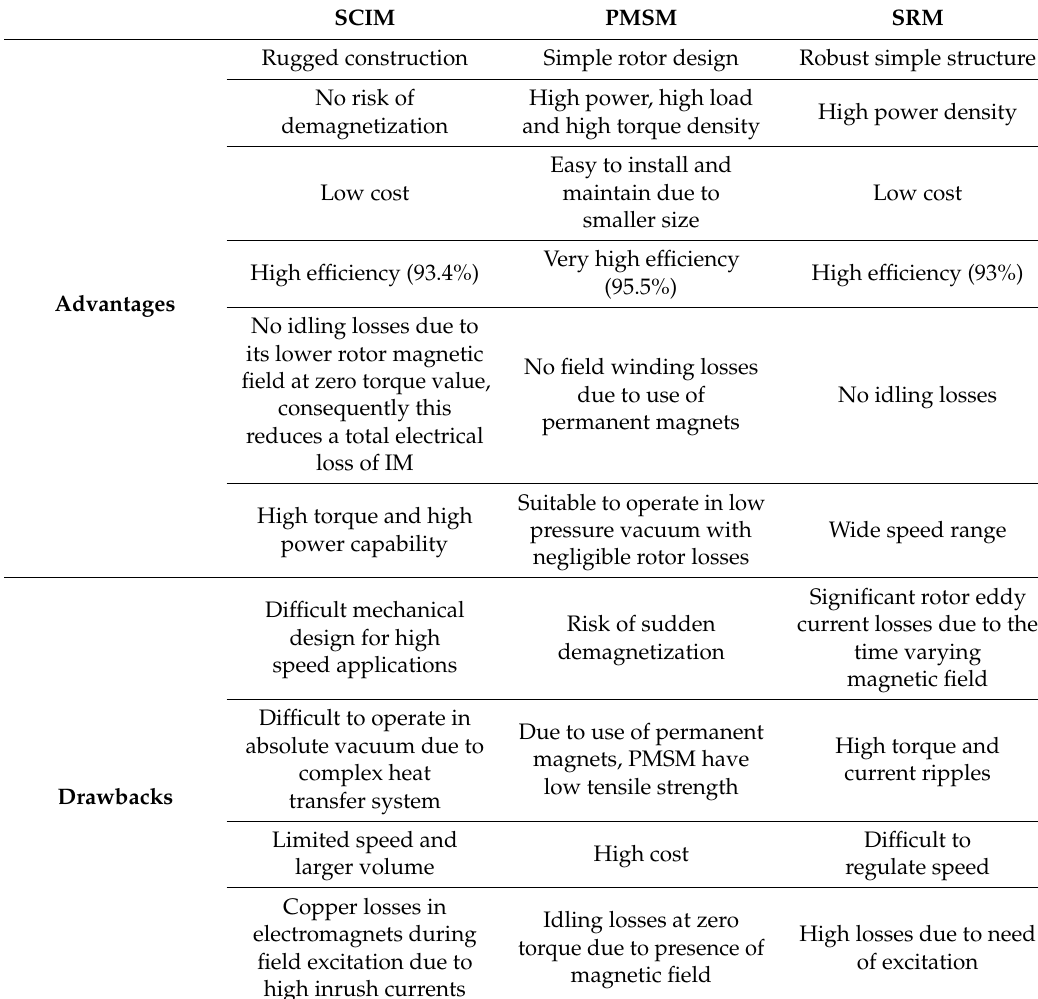
Table 1. Advantages and drawbacks of commonly used electrical machines in FESS